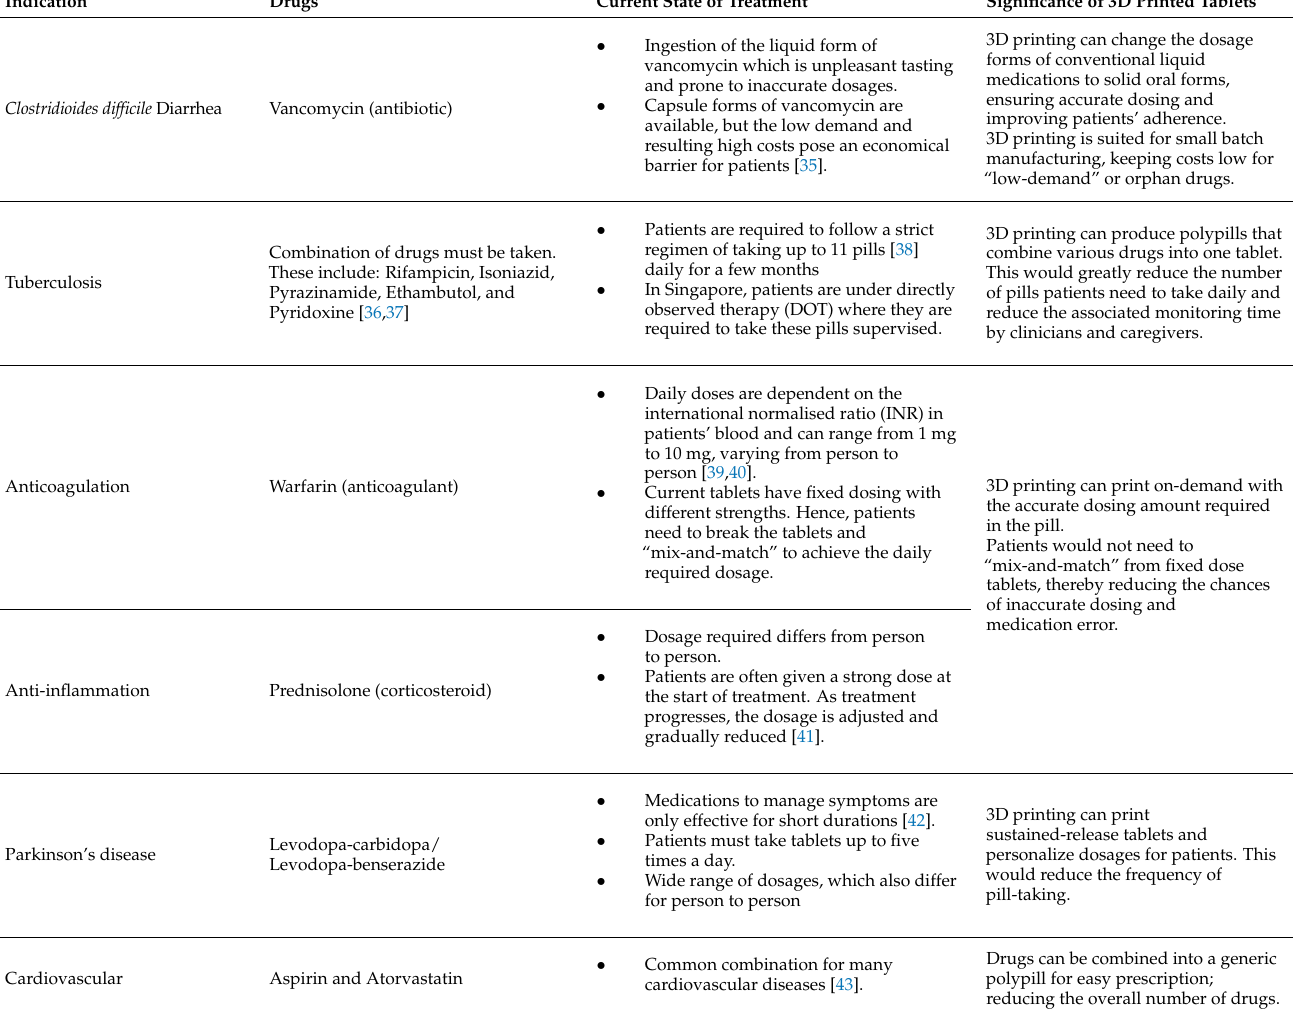
Table A2. Current state of treatment for diseases/drugs mentioned in questionnaire and the improve- ments that 3D printing can